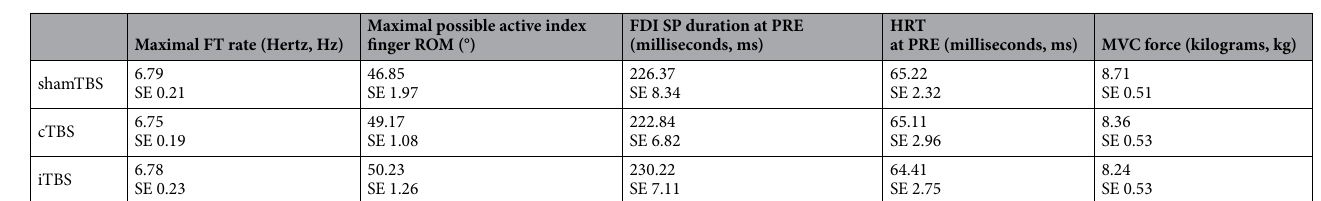
Table 1. Normalizing scores (mean across participants and standard error of the mean [SE]) for different sessions. Please see “Methods” for description. FT finger tapping, ROM range of motion amplitude, FDI SP first dorsal interosseous silent period, HRT half-relaxation time, MVC maximal voluntary contraction, SE standard error of the mean.